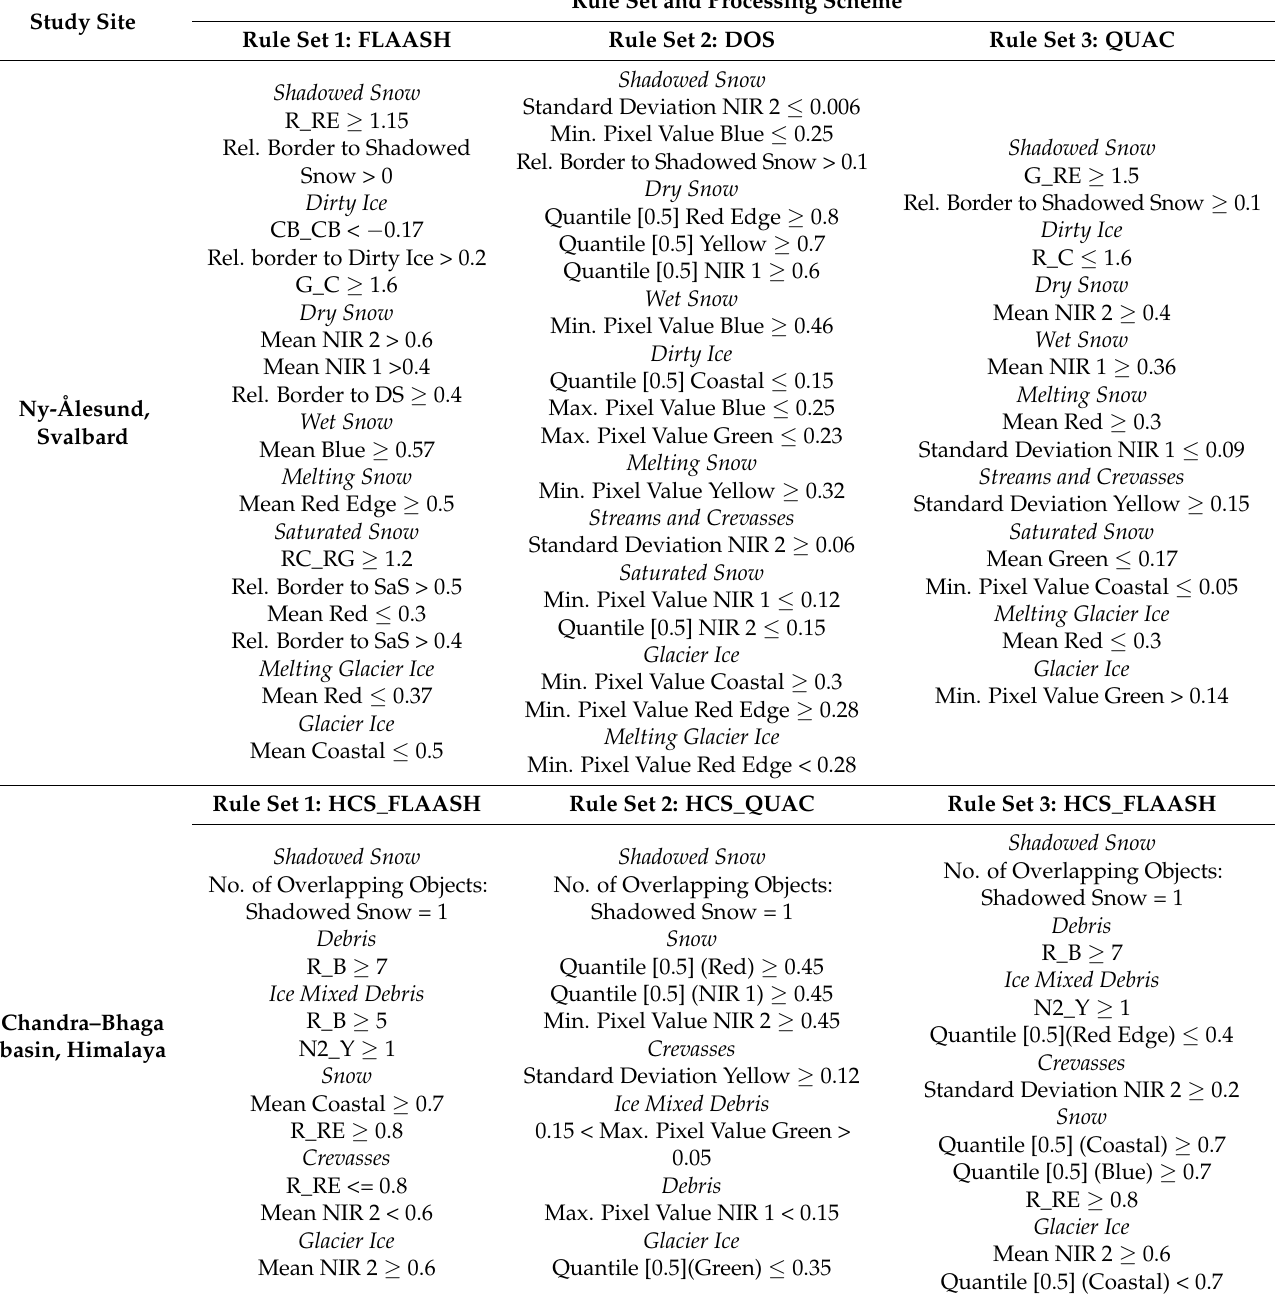
Table 3. Best performing rule sets for respective processing scheme for each study site based on individual overall accuracy and F1 score. Detailed rule sets for all processing schemes are available in Supplementary Table